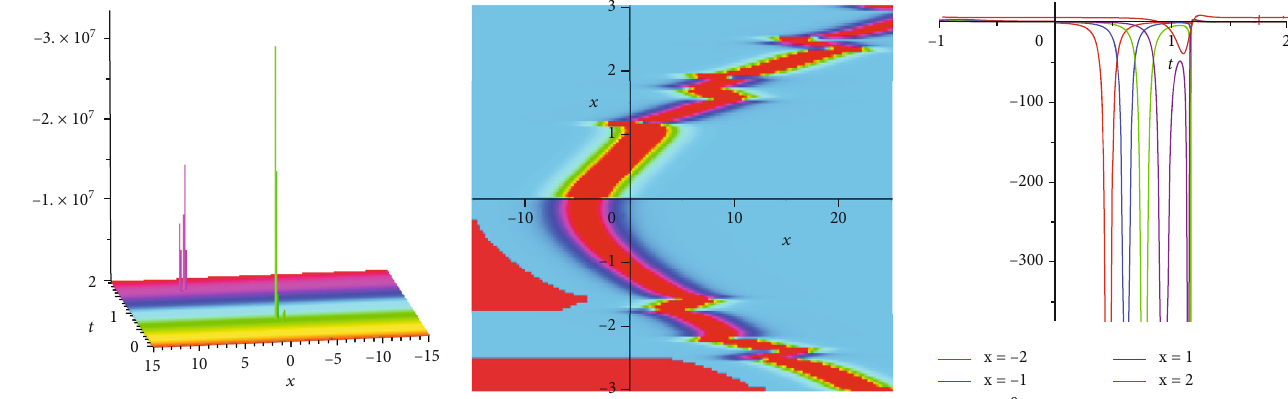
Figure 9: Plot of periodic wave solution (54) ð Σ